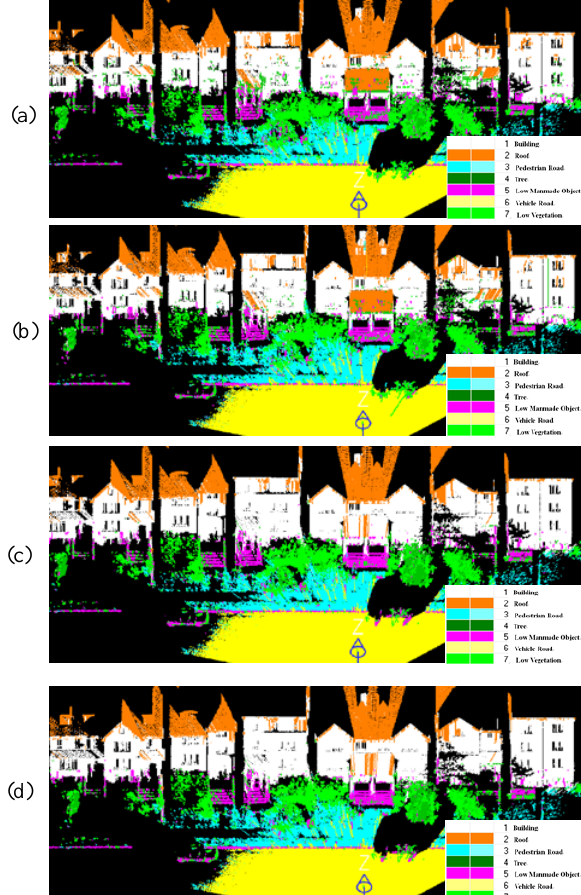
Figure 6. Classification results of Site B: (a) GMM-EM, (b) srCRF, (c) lrCRF and (d)